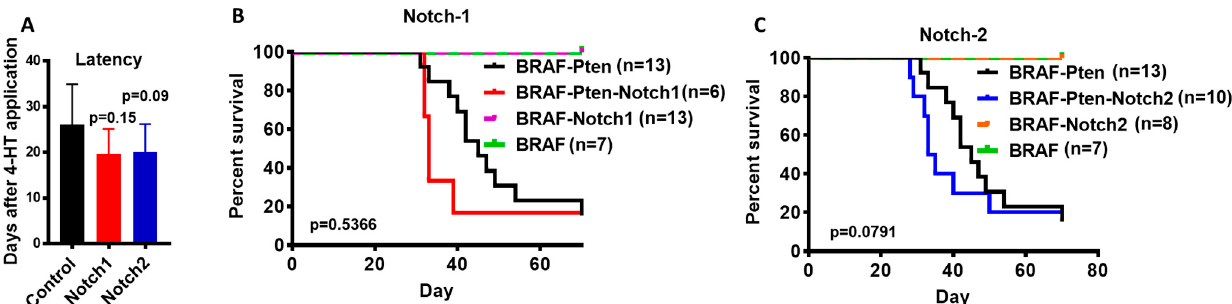
Figure 1. Role of Notch1 and Notch2 in melanomagenesis. ( A ) Tumor latency determined by the time between 4OHT application and the first appearance of a palpable tumor [Control BP mice ( n = 14), Notch1 knockout mice ( n = 5), Notch2 knockout mice ( n = 9)]. B and C. Kaplan–Meier Survival analysis. Each mouse was monitored until at least one tumor on any flank reached 10mm in any direction. In ( B ), BRAF-Pten mice (in black) served as controls. BRAF-Pten-Notch1 mice (in red); (BRAF) mice (in green) are controls for (BRAF-Notch1) mice (in purple). In ( C ), (BRAF-Pten) mice (in black) are controls for (BRAF-Pten-Notch2) mice (in blue); (BRAF) mice (in green) are controls for (BRAF-Notch2) mice in orange.